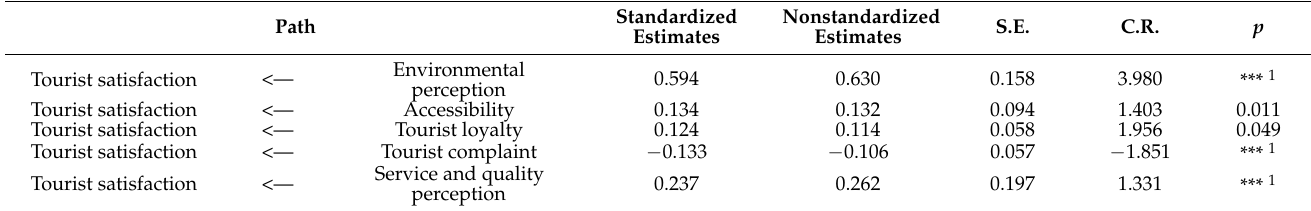
Table 7. Effect path analysis report.